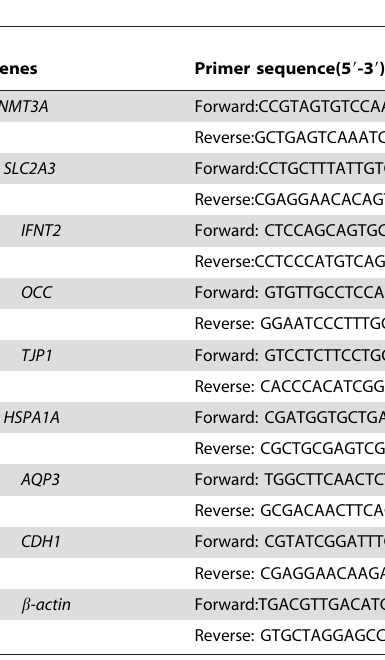
Table 1. Primers used in this